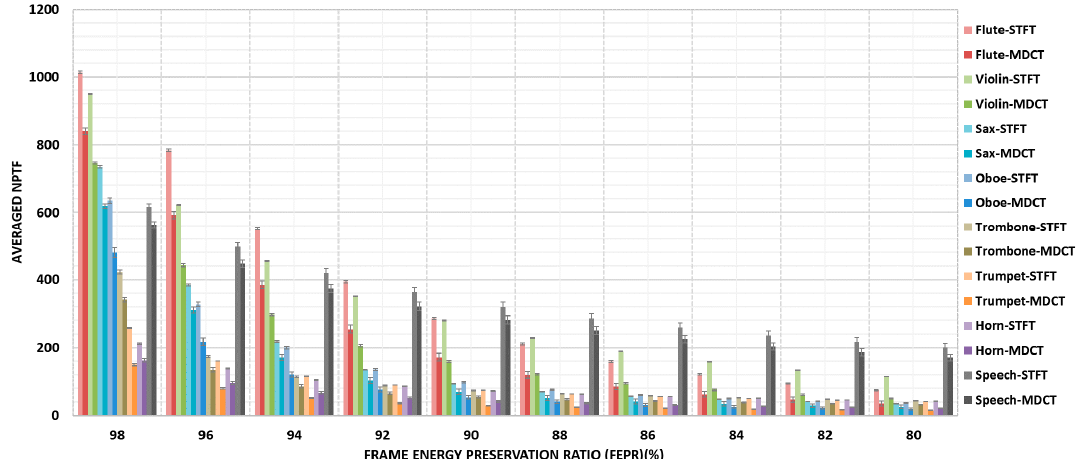
Figure A1. NPTF (Number of Preserved Time-Frequency Bins) results calculated from eight types of audio signals in various FEPR (Frame Energy Preservation Ratio) .